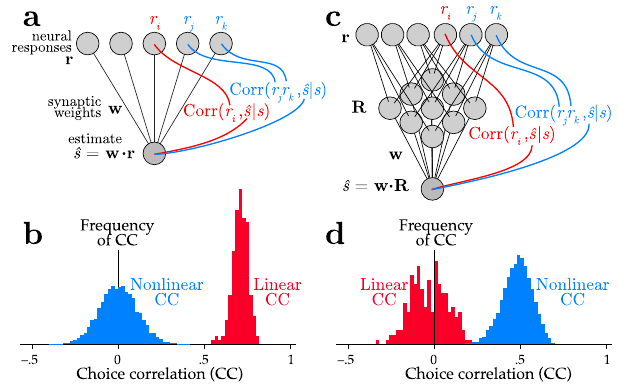
Fig. 3 Linear and nonlinear choice correlations successfully distinguish network structure. A linearly decoded population ( a ) produces nonzero linear choice correlations ( b ), while the nonlinear choice correlations are randomly distributed around zero. The situation is reversed for a nonlinear network ( c ), with insigni fi cant linear choice correlations but strong nonlinear ones ( d ). Here the network implements a quadratic nonlinearity, so the relevant choice correlations are quadratic as well, C jk ¼ Corr ð r j r k ; ^ s j s Þ